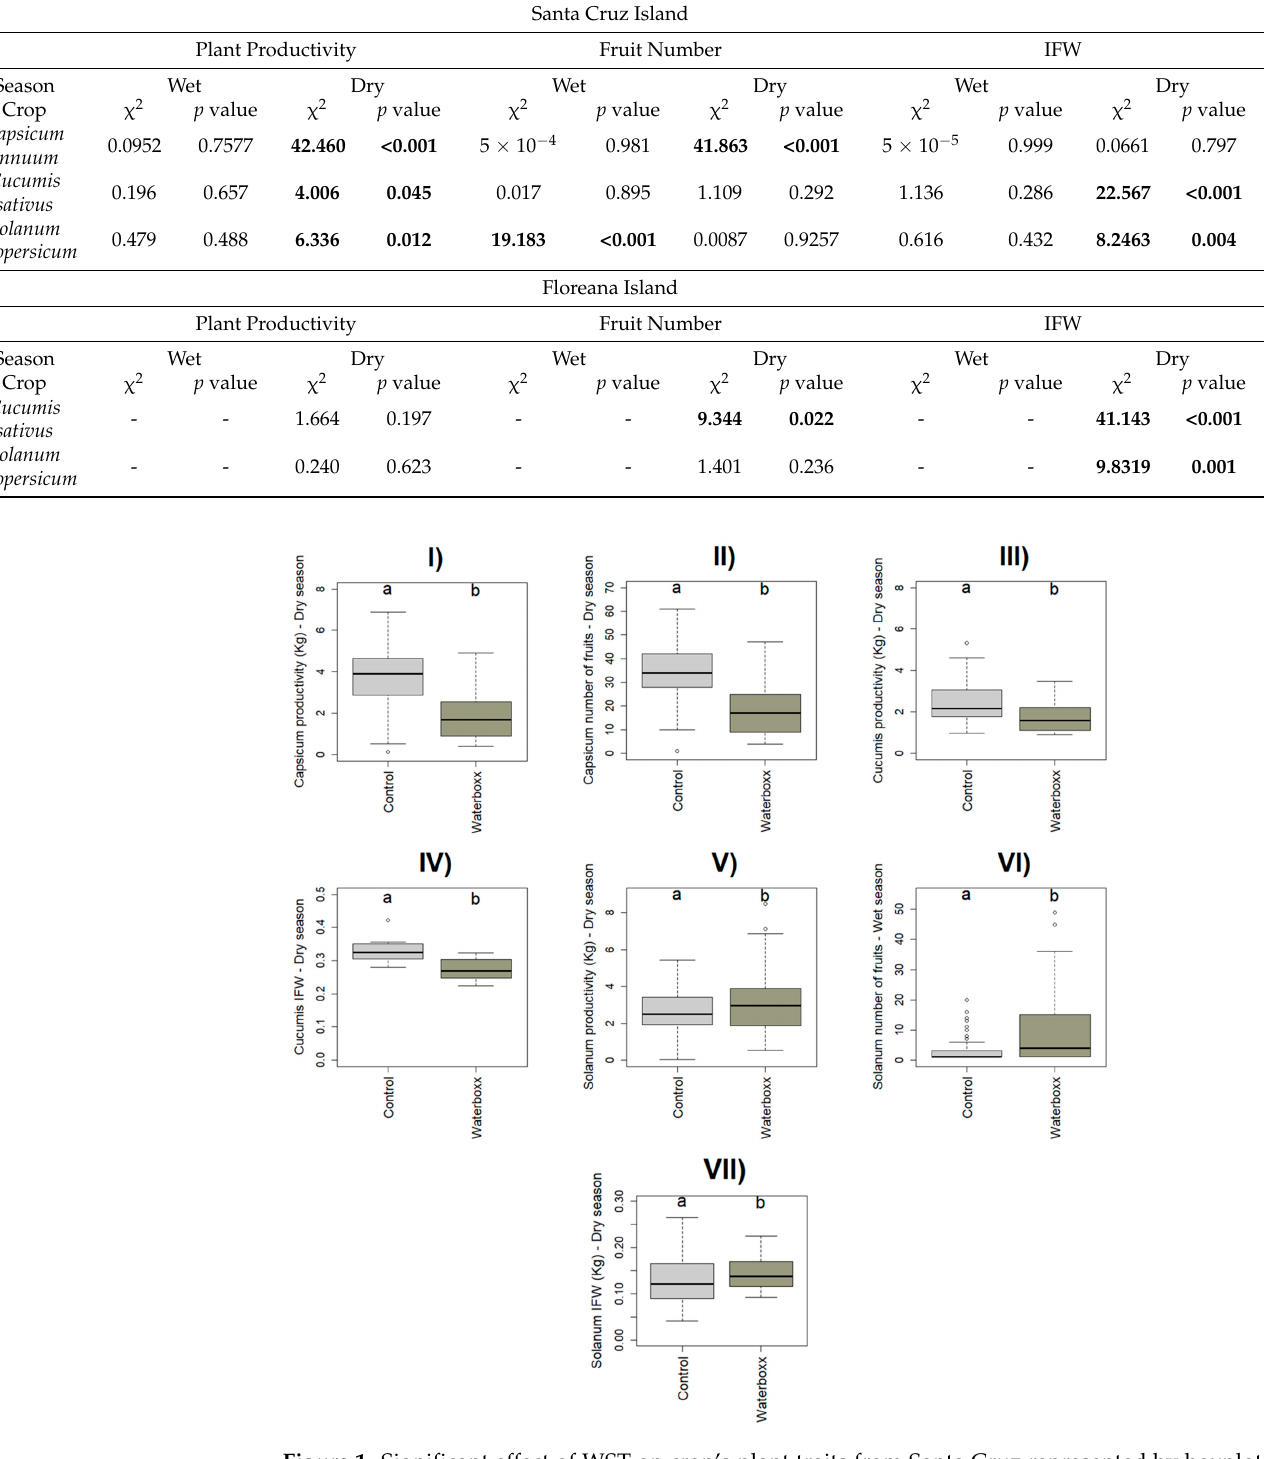
Table 1. Variability within plant traits based on the effect of treatment (WST, control). Values in bold are significant. Values in blank mean no productivity or deficient data on that season.